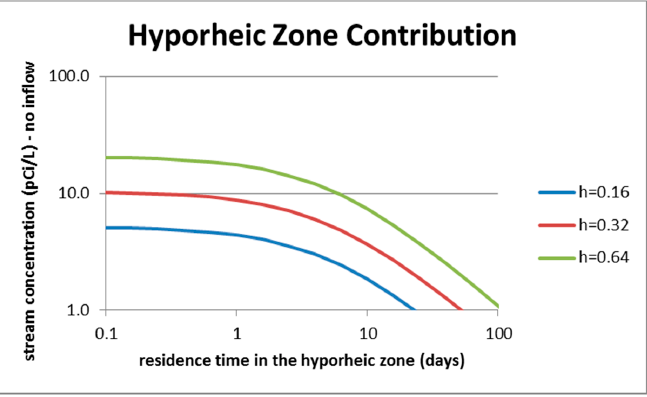
Figure A5. Contribution of hyporheic zone exchange to the stream water 222 Rn concentration, depending on residence time in the hyporheic zone, for different values of hyporheic zone thickness h .